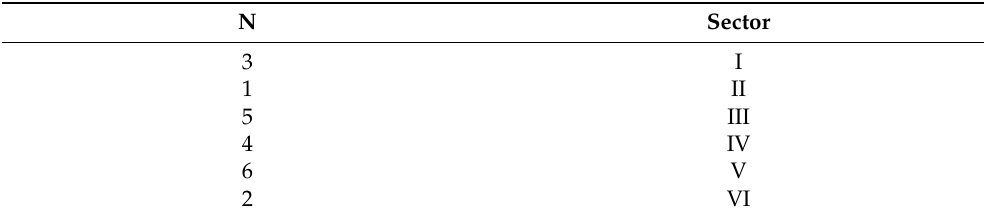
Table 1. Comparison between N and